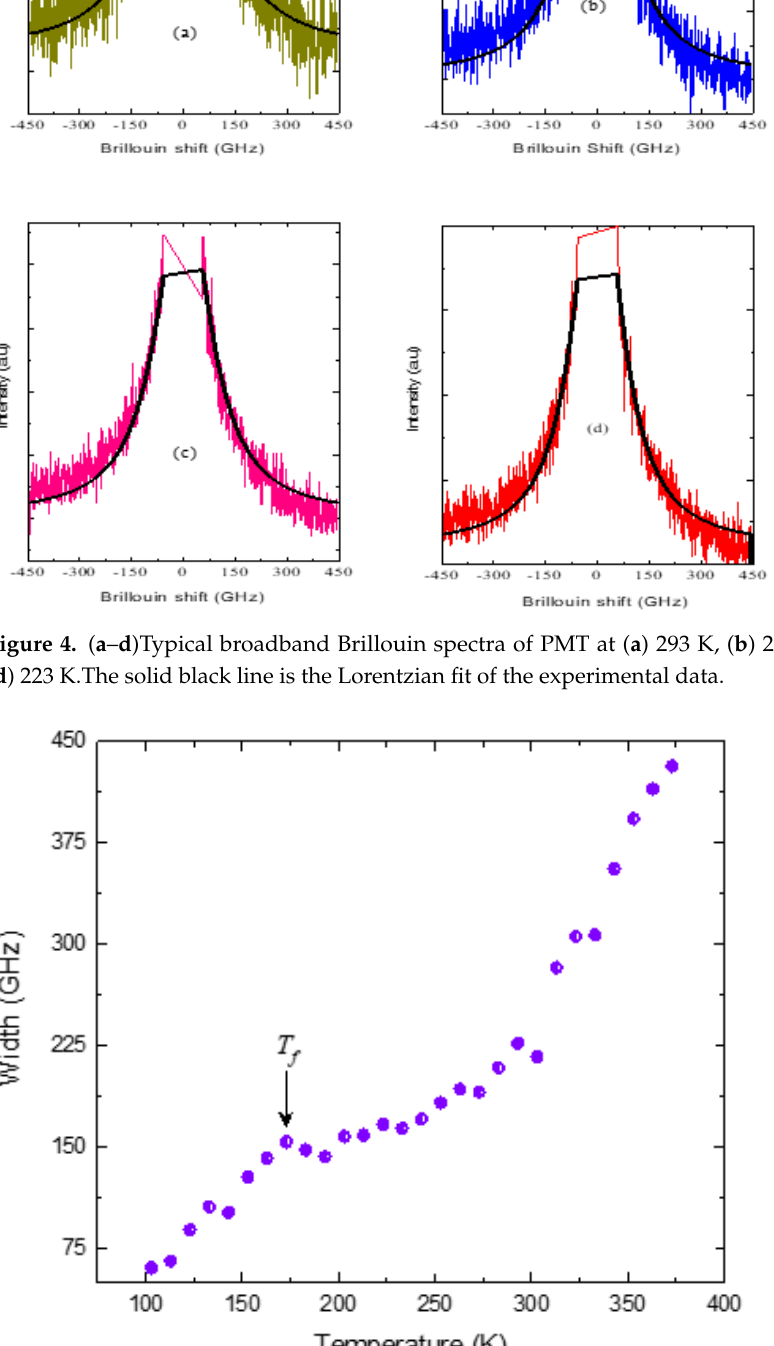
Figure 5. Temperature variation inthe width of the central peak of PMT (Reprinted with kind permission from Ref. [41]. 2015, the European Physical Journal (EPJ)).